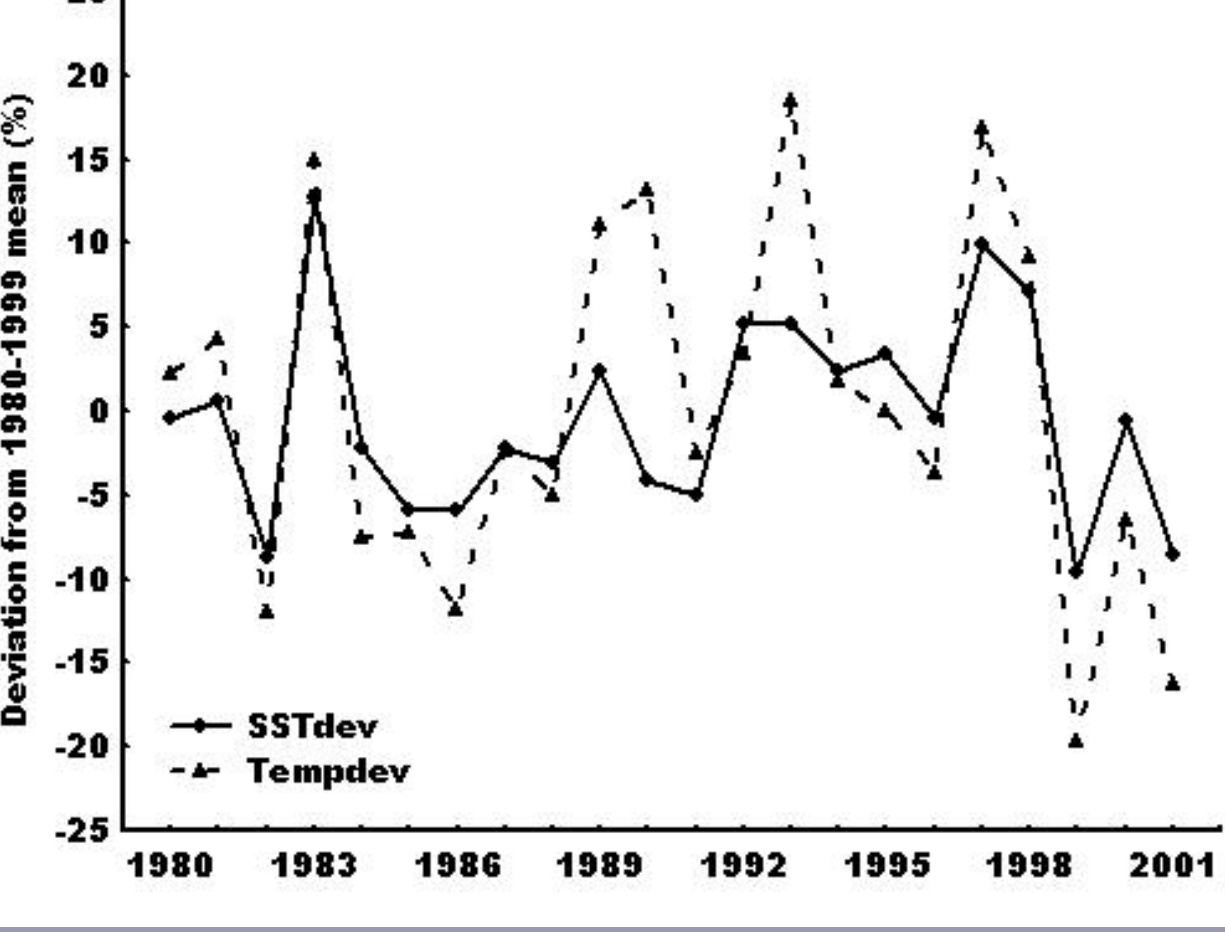
28 July 1999, 16 June–15 July 2000, and 18